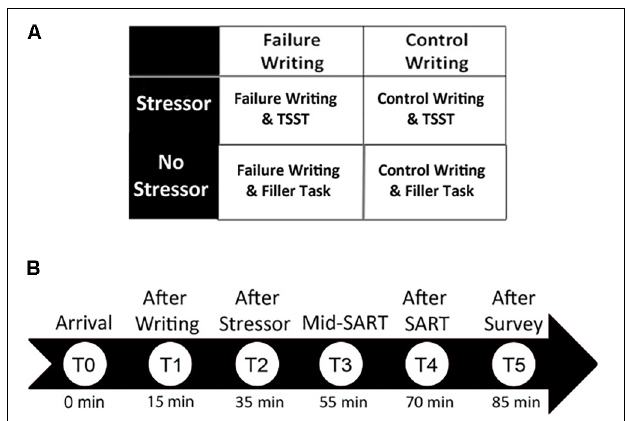
FIGURE 1 | Experimental method. (A) Participants were assigned to one of four conditions in which they wrote about a failure or a control topic, and then experienced a stressor or control activity. (B) Six salivary cortisol samples were obtained throughout the experiment. Because previous research has found that cortisol peaks about 20 min after a stressor is experienced, all samples represent peak cortisol as a result of the previous event.